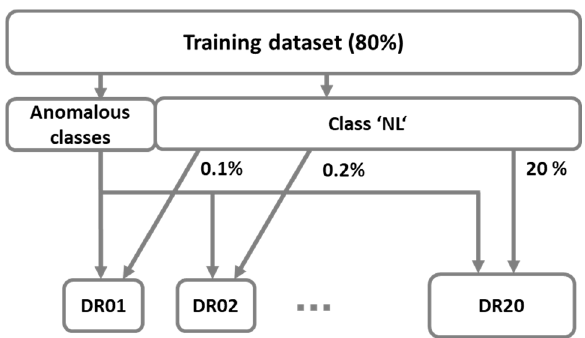
Figure 3. Determination of balanced datasets DRi with randomly selected samples from class ‘NL’.